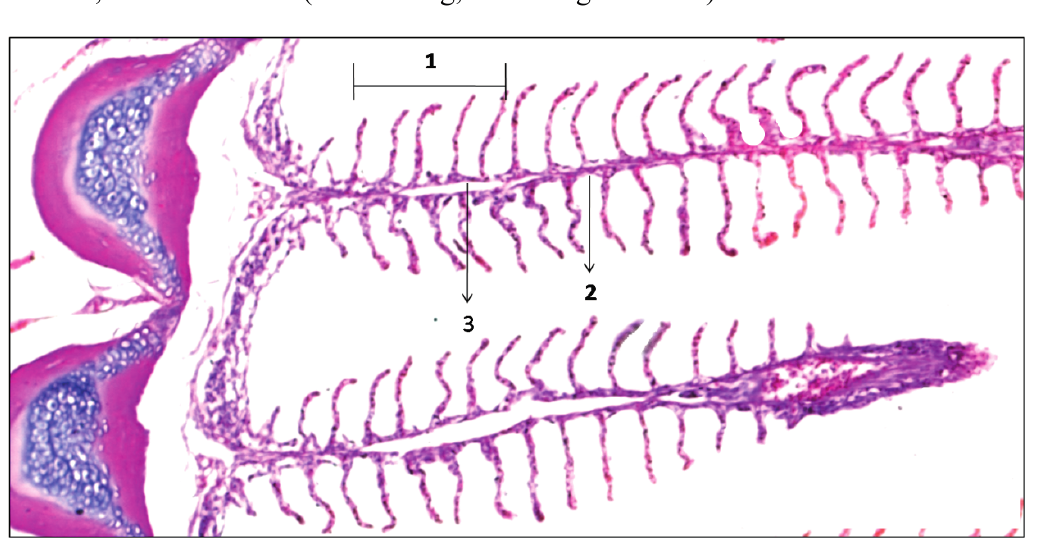
Figure 2. Normal gill filaments of C. undecimalis : 1: secundary lamella; 2: filament epithelium; 3: venous sinus (HE staining, 100× magnification).